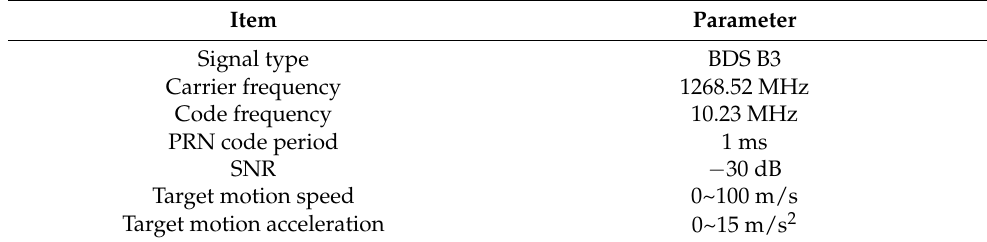
Table 2. Simulation